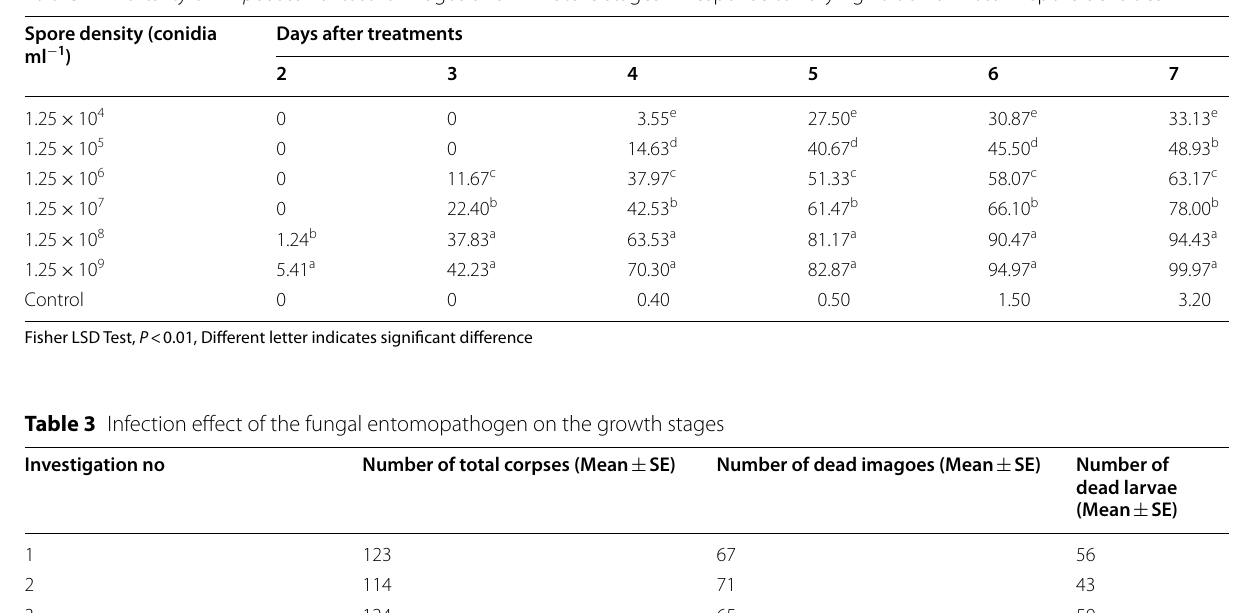
Table 2 Mortality of Empoasca flavescens imagos and immature stages in response to varying Verticillium lecanii spore densities Spore density (conidia ml − 1 )